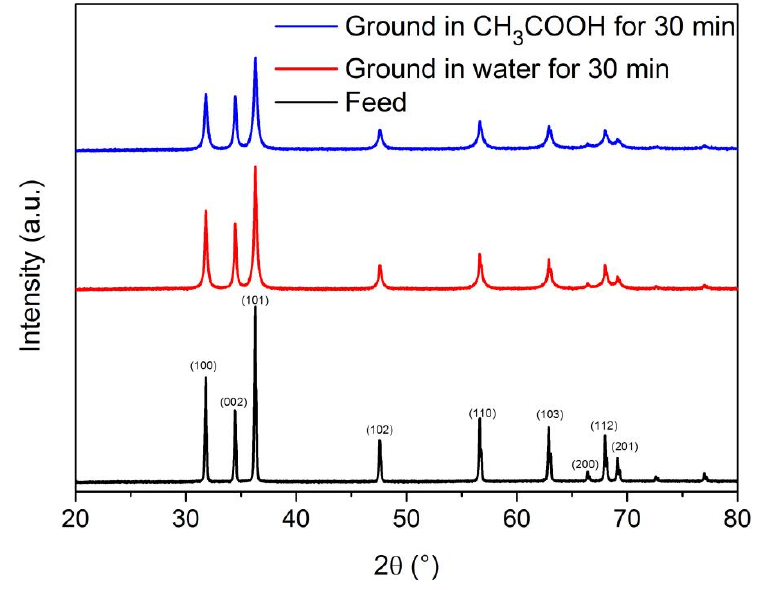
Figure 8. XRD patterns of feed and zinc oxide particles ground for 30 min in water or in a CH 3 COOH solution at a low concentration of 0.010 mol/L.